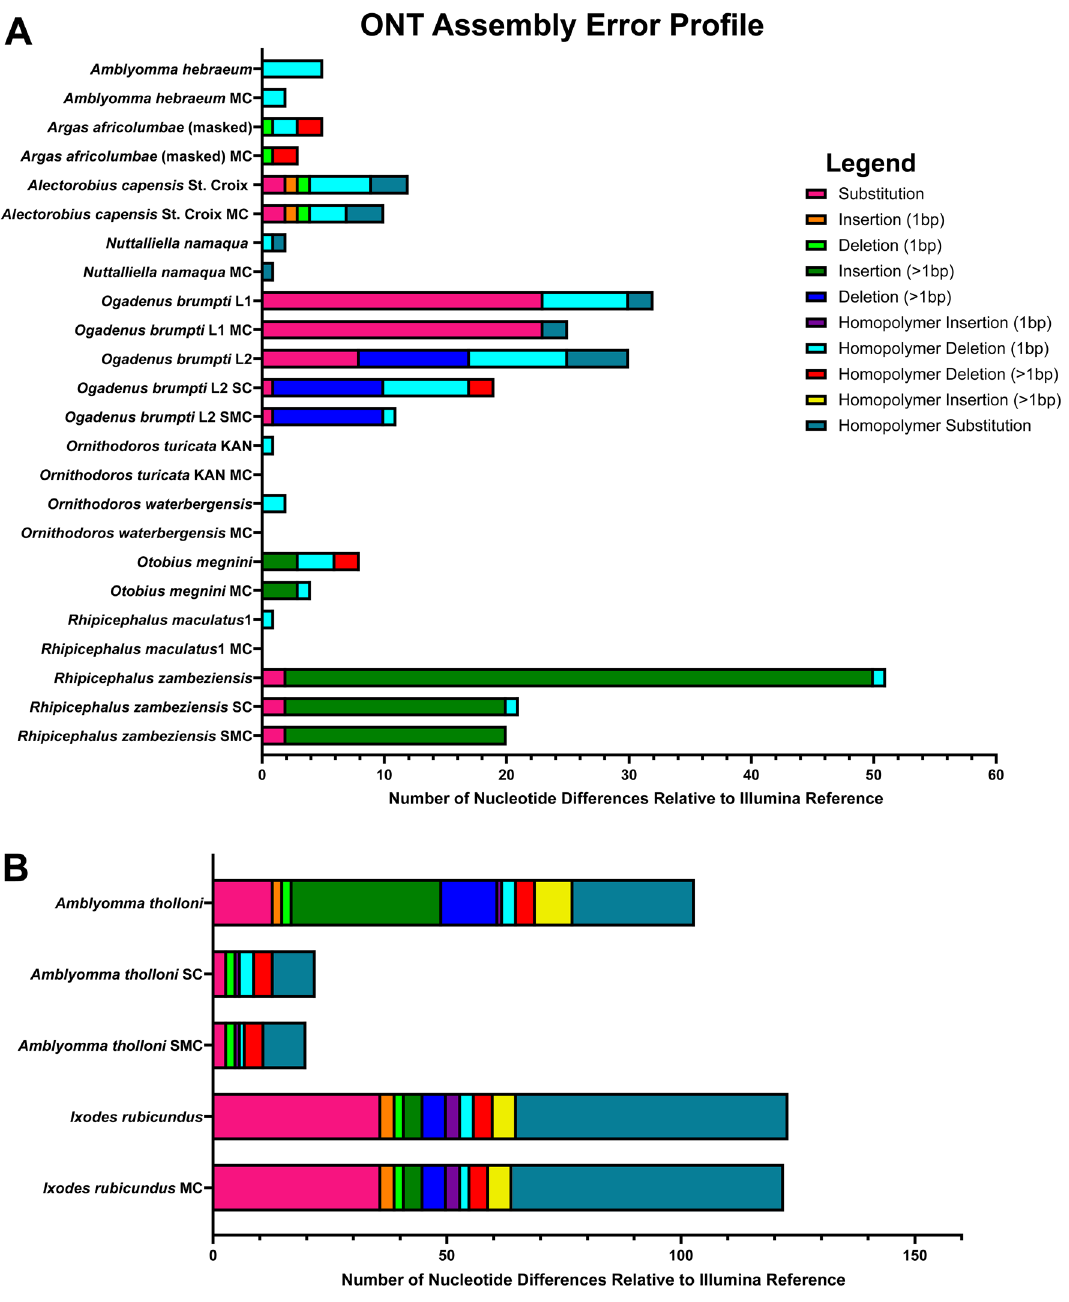
Figure 3. ONT assembly error profile. We characterized the nucleotide differences between the ONT assemblies and the Illumina references to determine an error profile. The error profile was plotted in two different groups, those assemblies with < 100 bp differences ( A ) and those with > 100 bp differences ( B ). The number of nucleotide differences is classified for each assembly and after any error correction steps taken. Homopolymers are defined as any span of the same nucleotide > 2. SC Sanger correction, MC manual correction, SMC Sanger correction followed by manual